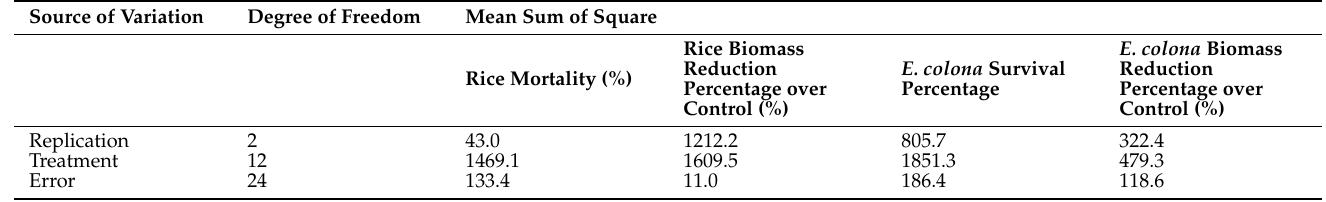
Table A4. Analysis of variance for different parameters for pendimethalin doses in Experiment